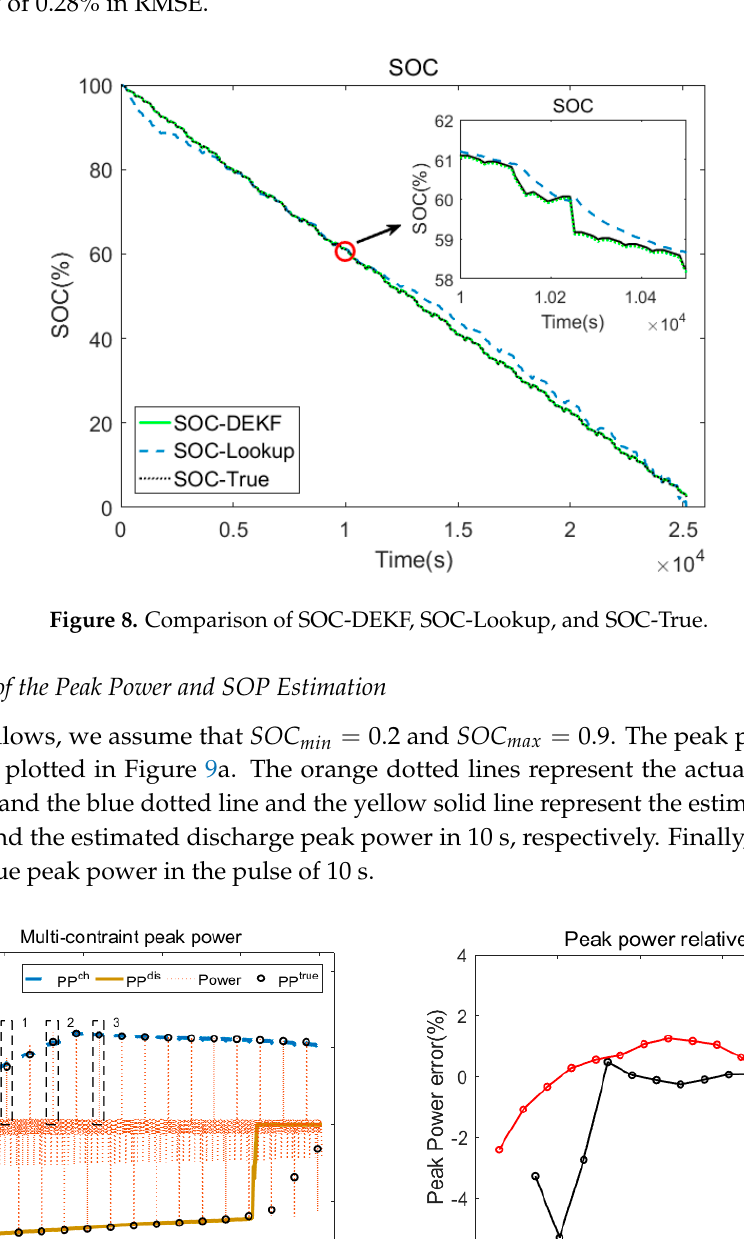
( b ) Figure 10. Battery peak power under multiple constraints: ( a ) charge peak power; ( b ) discharge peak power. Based on Equations (53) and (54), the results of SOP estimation and relative error results are shown in Figure 11a,b, respectively.